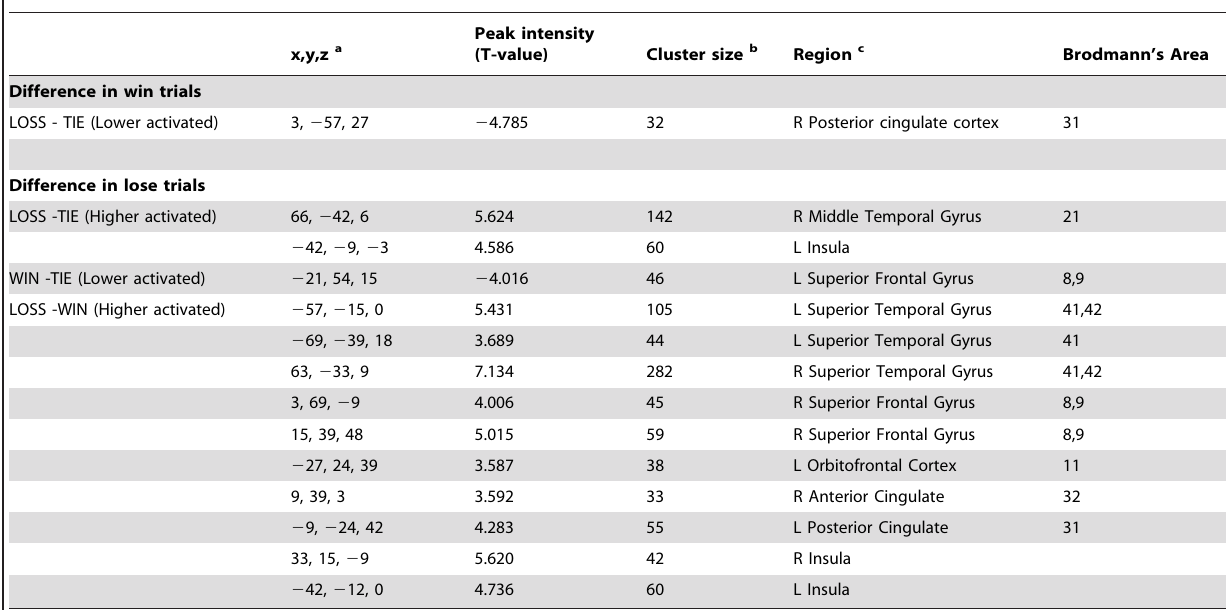
Table 1 : Regional brain activity changes in different comparisons